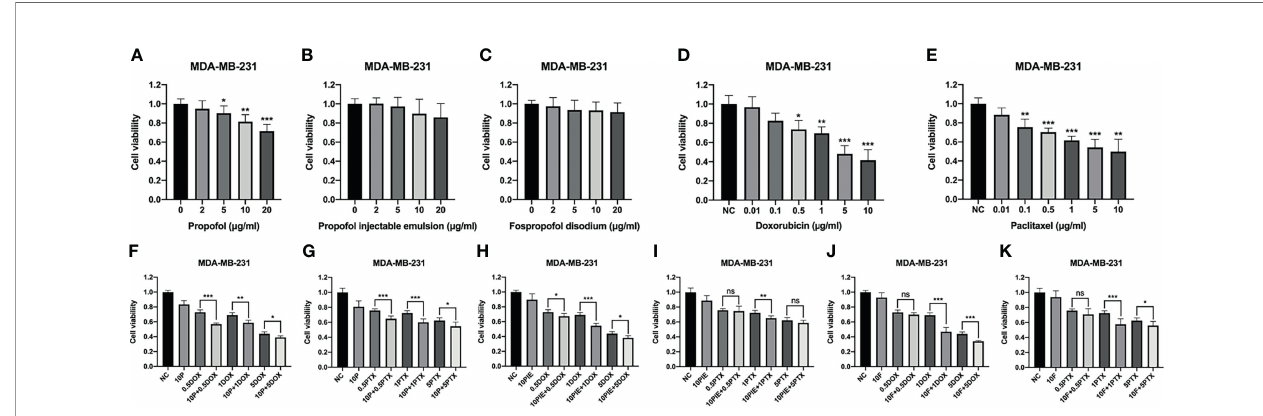
FIGURE 1 | Cell viability of MDA-MB-231 cells treated with propofol/PIE/fospropofol disodium, doxorubicin/paclitaxel, or drug combinations at different concentrations. (A – C) Effects of propofol, PIE or fospropofol disodium on MDA-MB-231 cell viability. (D, E) Effects of doxorubicin or paclitaxel on MDA-MB-231 cell viability. (F, G) Effects of propofol with doxorubicin or paclitaxel on MDA-MB-231 cell viability. (H, I) Effects of PIE with doxorubicin or paclitaxel on MDA-MB-231 cell viability. (J, K) Effects of fospropofol disodium with doxorubicin or paclitaxel on MDA-MB-231 cell viability. Cell viability was determined using CCK-8 assays, and each experiment was repeated at least three times. NC, normal control; 10P, 10 µg/ml propofol; 10PIE, 10 µg/ml propofol injectable emulsion; 10F, 10 µg/ml fospropofol disodium; 0.5DOX, 0.5 µg/ml doxorubicin; 1DOX, 1 µg/ml doxorubicin; 5DOX, 5 µg/ml doxorubicin; 0.5PTX, 0.5 µg/ml paclitaxel; 1PTX, 1